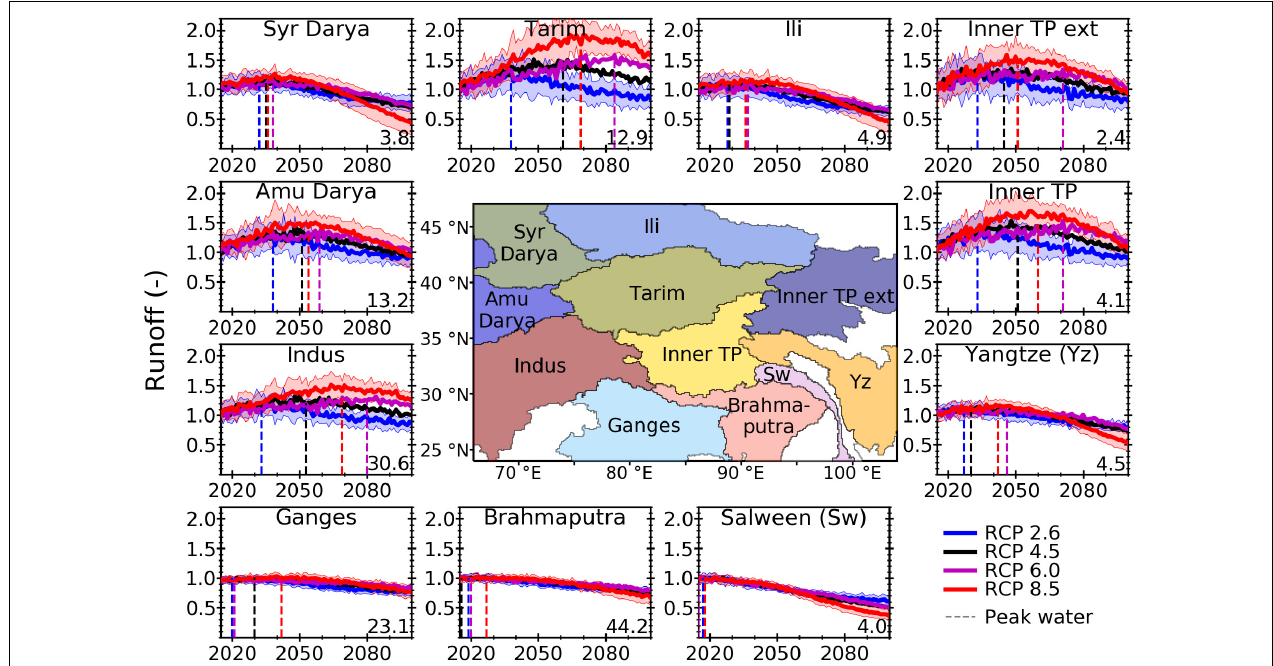
FIGURE 6 | Time series of multi-GCM means ( ± 1 standard deviation) of annual fixed-gauge glacier runoff (i.e., the runoff from the initially glacierized area) in eleven river basins for each RCP scenario from 2015 to 2100, relative to the mean annual fixed-gauge glacier runoff from 2000 to 2015 (given in bottom right in Gt yr - 1 ). Uncertainty only shown for RCP 2.6 and RCP 8.5 for clarity. Dashed lines show peak water for each RCP. Center map shows major river basins in study area (Vörösmarty et al., 2000). Abbreviations in center map are Sw, Salween; TP, Tibetan Plateau; Yz,